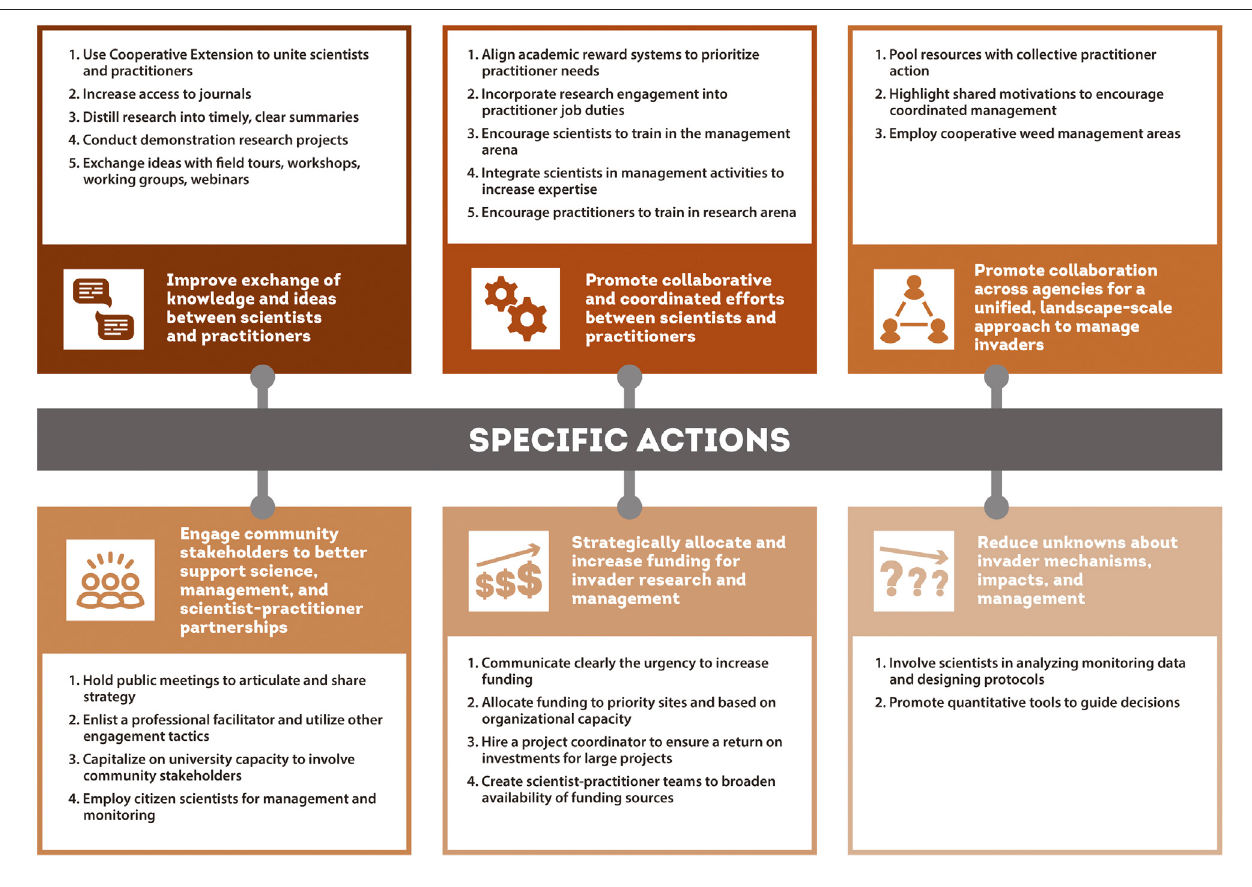
FIGURE3| Manyconcretestepscanbetakenbyscientistsandmanagerstoimprovescience-basedmanagementofwetlandinvaders.Thesespeci fi cactionstendto be collaborative, rather than the action of people in just one role (practitioner or scientist), and in many cases they represent intentional actions needed to bridge the implementationgap.Someofthesespeci fi cactionsarealreadyfrequentlyinusewhereasotherswillrequireadditionalconsiderationorrenewedattention.Regardless,onthe whole these speci fi c actions should be feasible for many organizations and contexts when adopting an overarching structured approach might be unworkable.